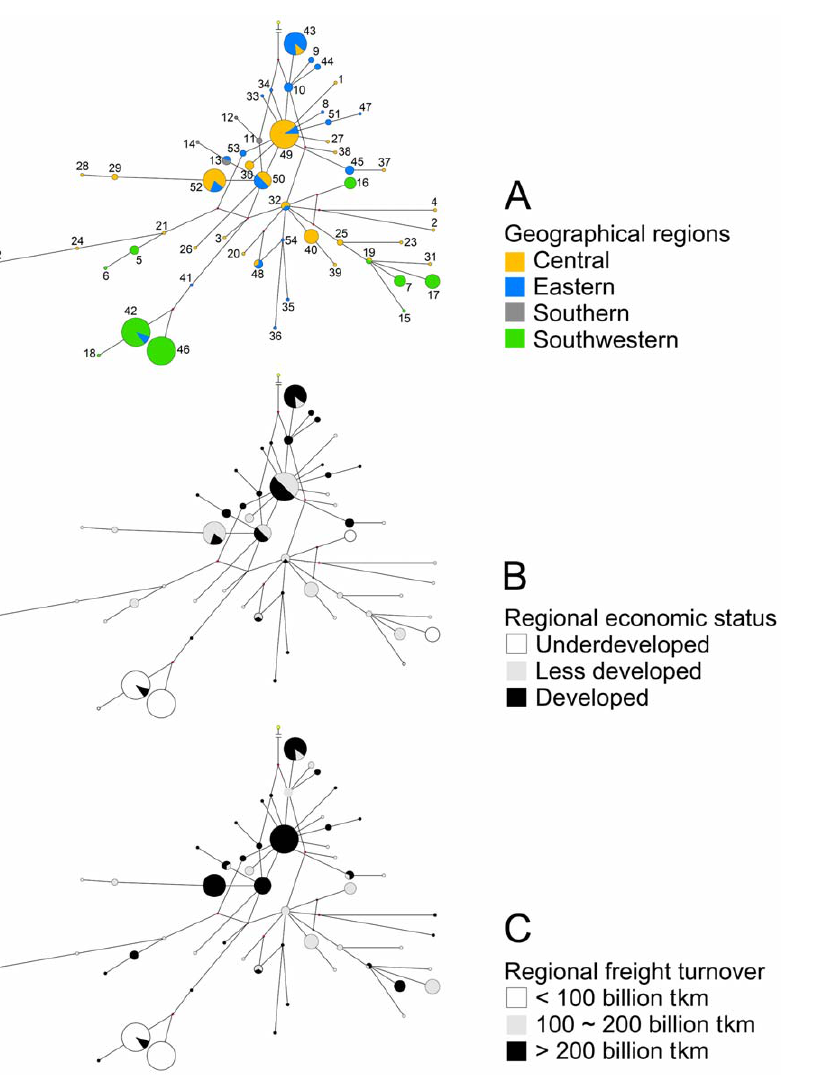
Figure 3. Depicted are the median joining networks of the 54 haplotypes of M.alternatus as categorized by (A) the geographical regions of mainland China, (B) the regional economic status, and (C) the regional freight turnover of the 14 provinces within the study region. Node size is proportional to the number of individuals contained in each haplotype; the numbers of haplotypes correspond to the data presented in Table 2.